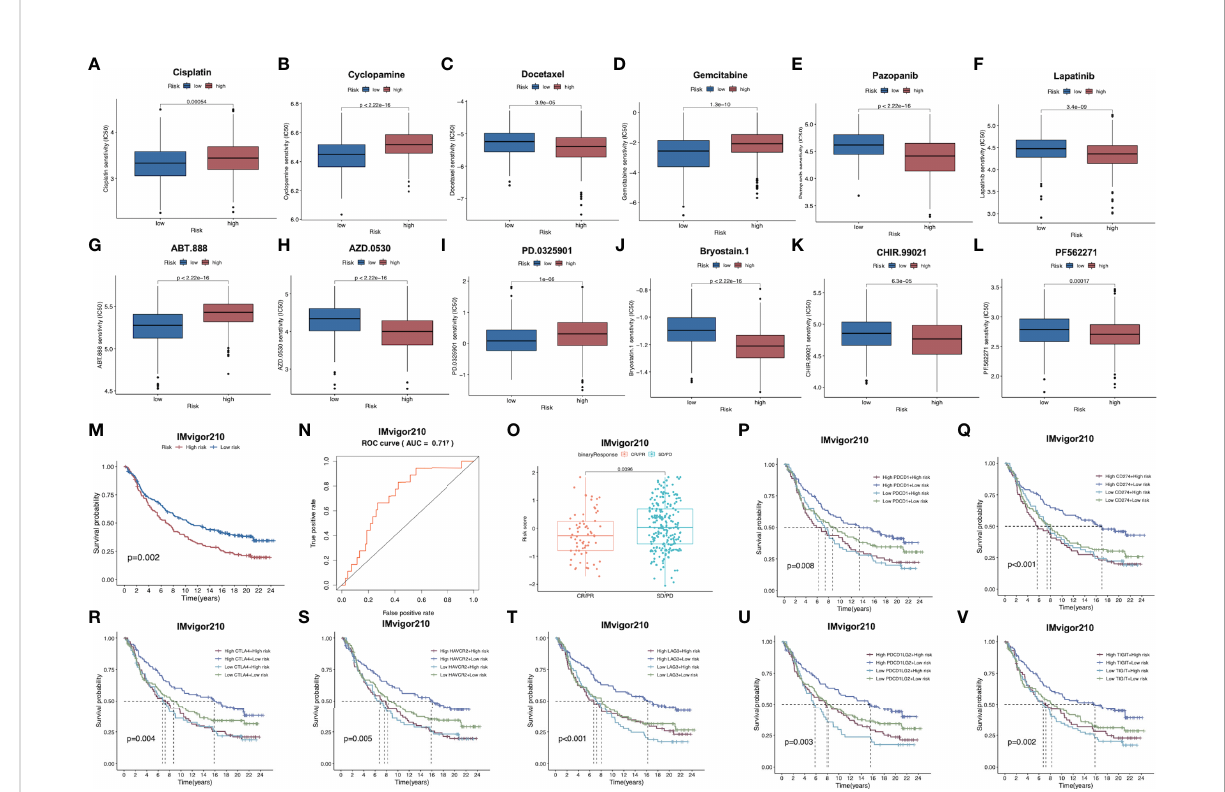
FIGURE 7 (A – L) Corrections between risk score and chemotherapeutic sensitivity. (M) Kaplan-Meier survival curves of patients in low-risk group and high- risk group of the IMvigor210 cohort. (N) Relationships between risk scores and response to immunotherapy in the IMvigor210 cohort (O) Differences in risk scores between patients with SD/PD and CR/PR in IMvigor210 cohort.. (P – V) Effect of expression of 5 key immune checkpoints (PD-1, PD-L1, PD-L2, CTLA4, TIGIT, LAG3 and HAVCR2, respectively on OS of patients in low- and high-risk groups in IMvigor210 cohort. OS, overall survival; PR, partial response; CR, complete response; PD, progressive disease; SD, stable